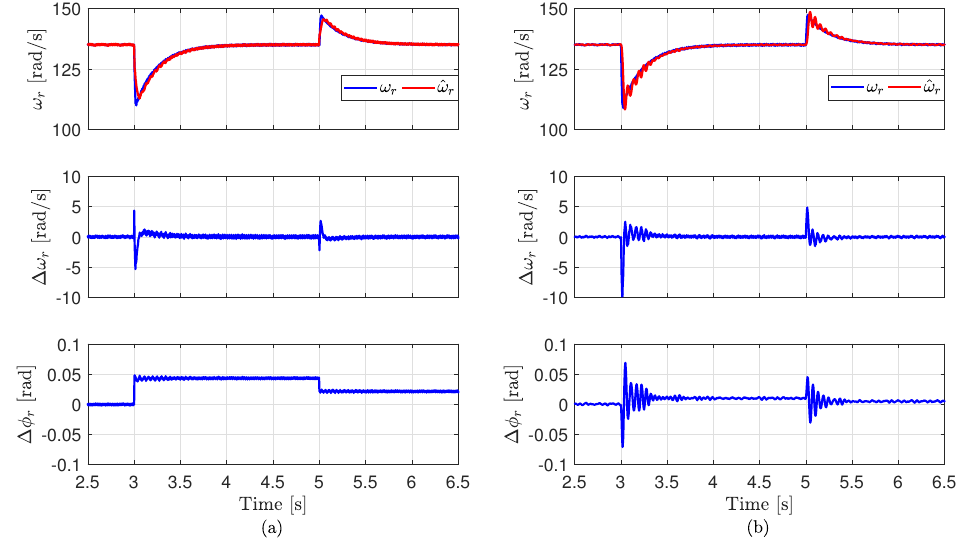
Figure 7. Experimental results for step changes in the electro-magnetic torque T (cid:63) e : ( a ) MRAS-FS and ( b ) conventional